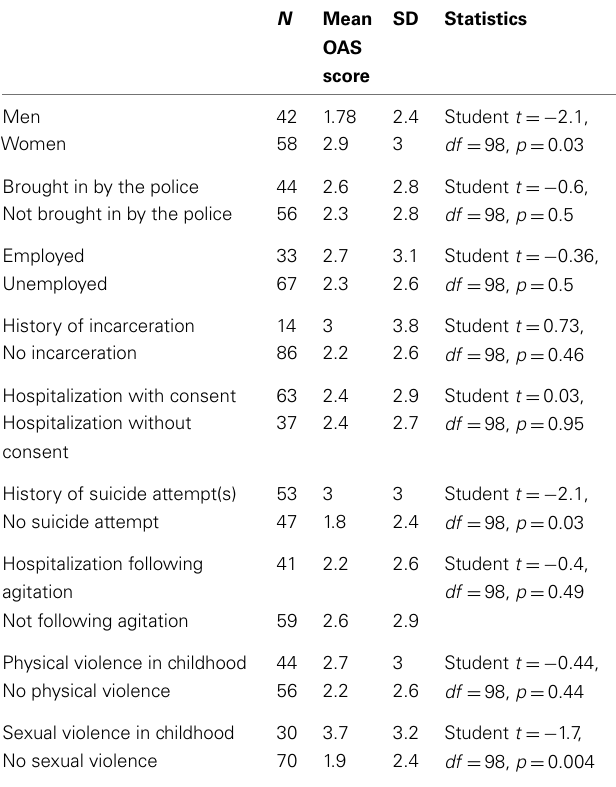
Table 1 | Comparison of agitation (OAS scores) according